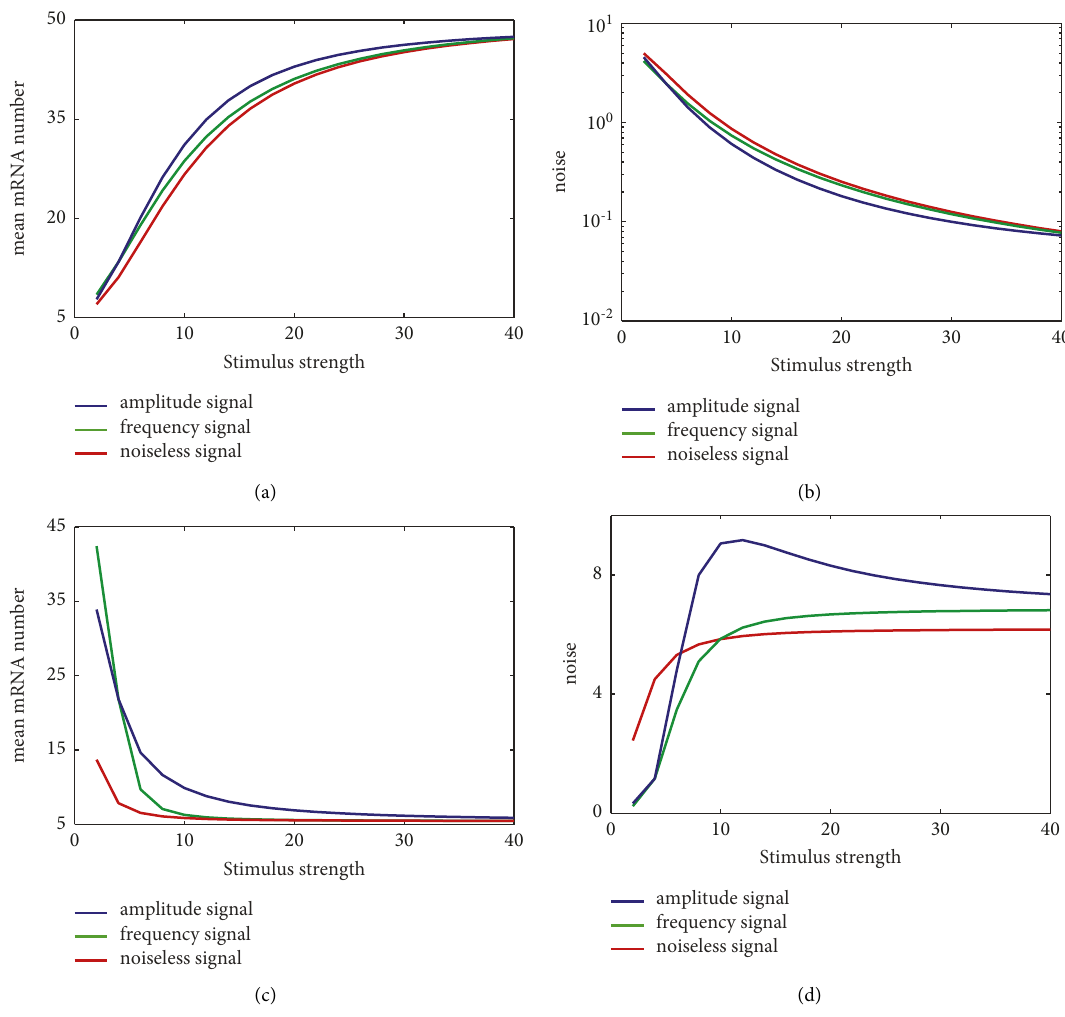
Figure 6: The mean mRNA number (a, c) and expression noise (b, d) of downstream gene expression under the AM paradigm. (a, b) indicates that the upstream signal is an activator, while (c, d) indicates that the upstream signal is a repressor. The red line represents the upstream stimulus signal as noiseless, and the green line represents the upstream stimulus signal as random with the burst frequency ( α ) changing and the burst size ( β ) being equal to 2, while the blue line represents the upstream stimulus signal as also random with the burst frequency ( α ) being equal to 2 and the burst size ( β ) changing. The other parameters are the same as in Figure